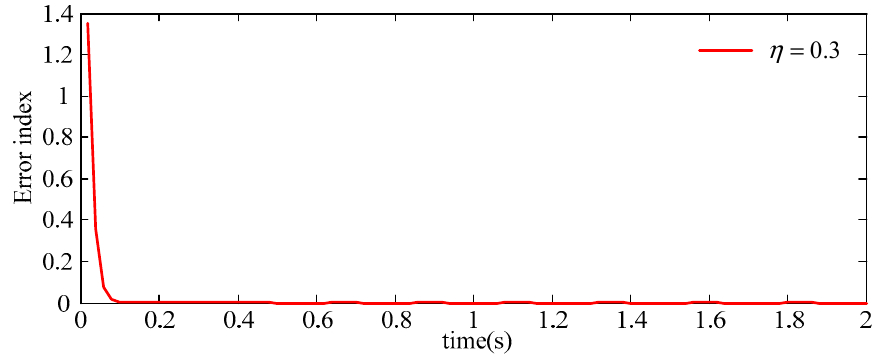
Figure 7. Network approximation error convergence curve.